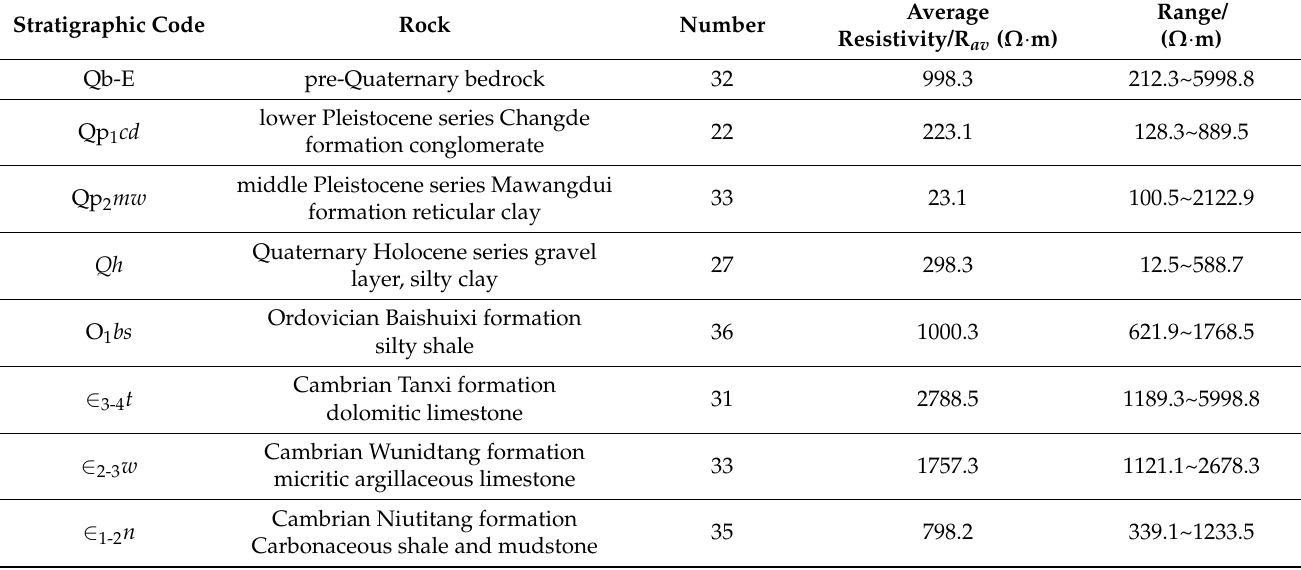
Table 1. Resistivity characteristics of different strata in the study area.